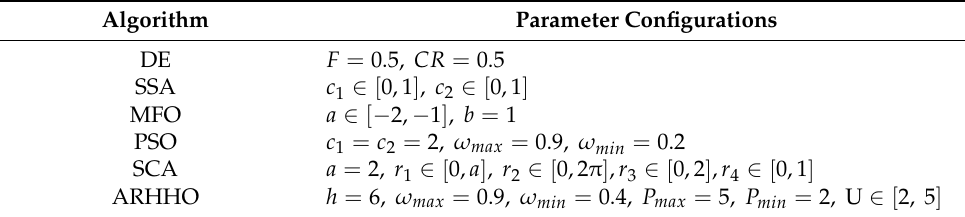
Table 1. Parameter setting.